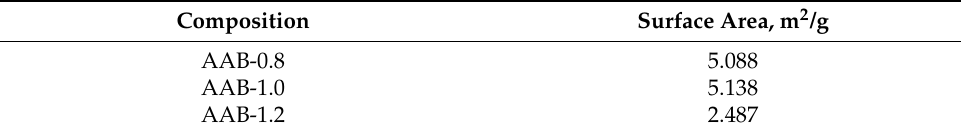
Figure 6. X-ray diffractogram (XRD) of the studied alkali-activated binders on the 28th day. Table 5. The surface areas of the alkali-activated